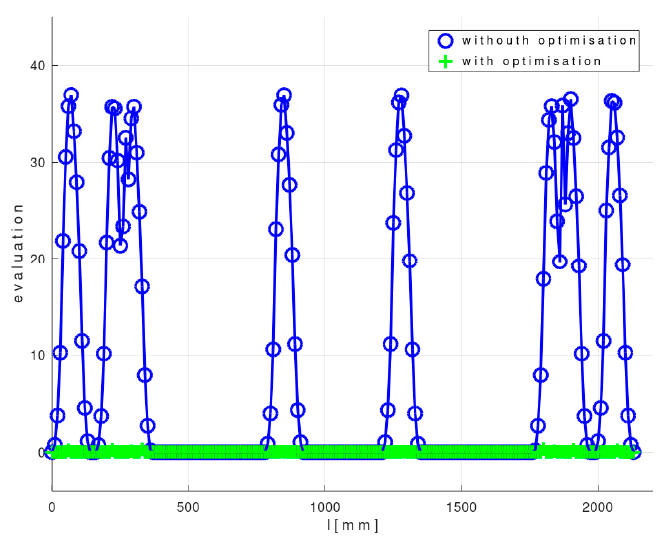
ϕ ( i ) ω ( i ) ) for z ( i ) opt , opt , opt , opt ωϕ , z H , 0, 0 ) for non-optimal REE trajectory during the for optimal BCS BCS zxF for non-optimal REE trajectory during the passage of BCSBCS HH =≤≤ Ni ). ωϕ for optimal zxF for non-optimal REE trajectory during the passage of BCSBCS HH =≤≤ Ni ).